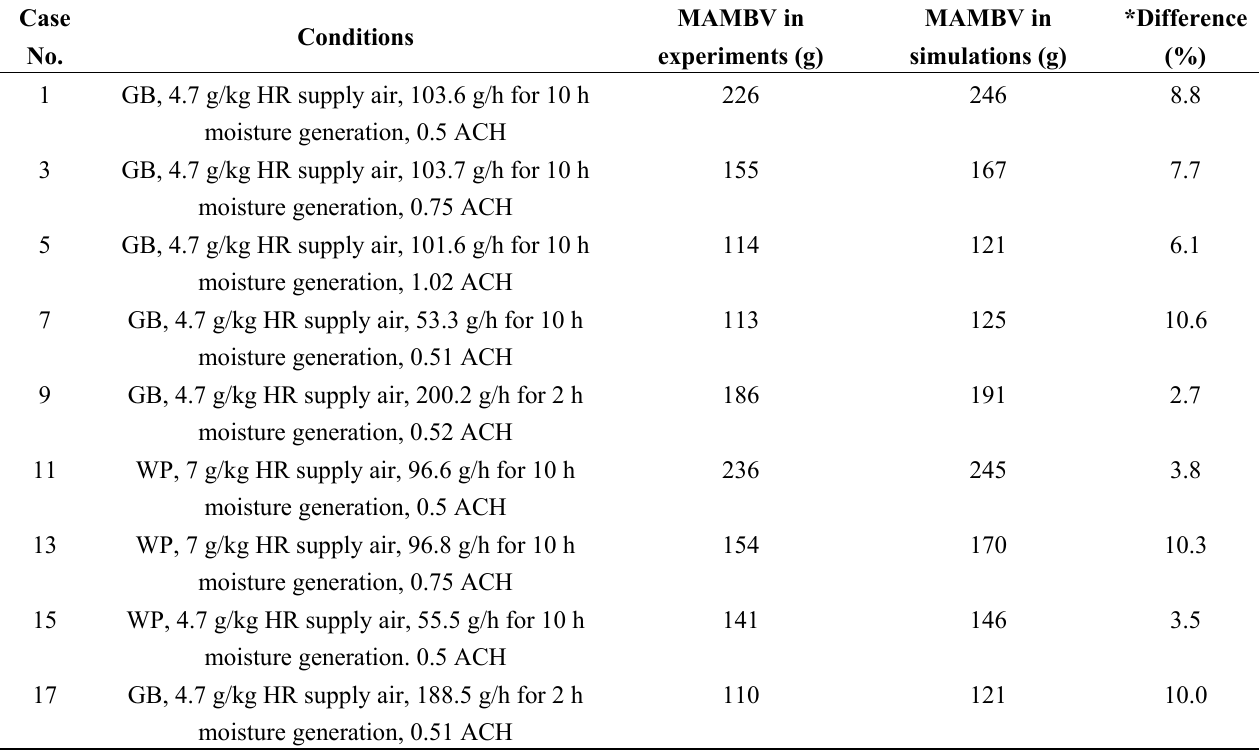
Table 2. Comparison of MAMBVs obtained from simulation results and experimental